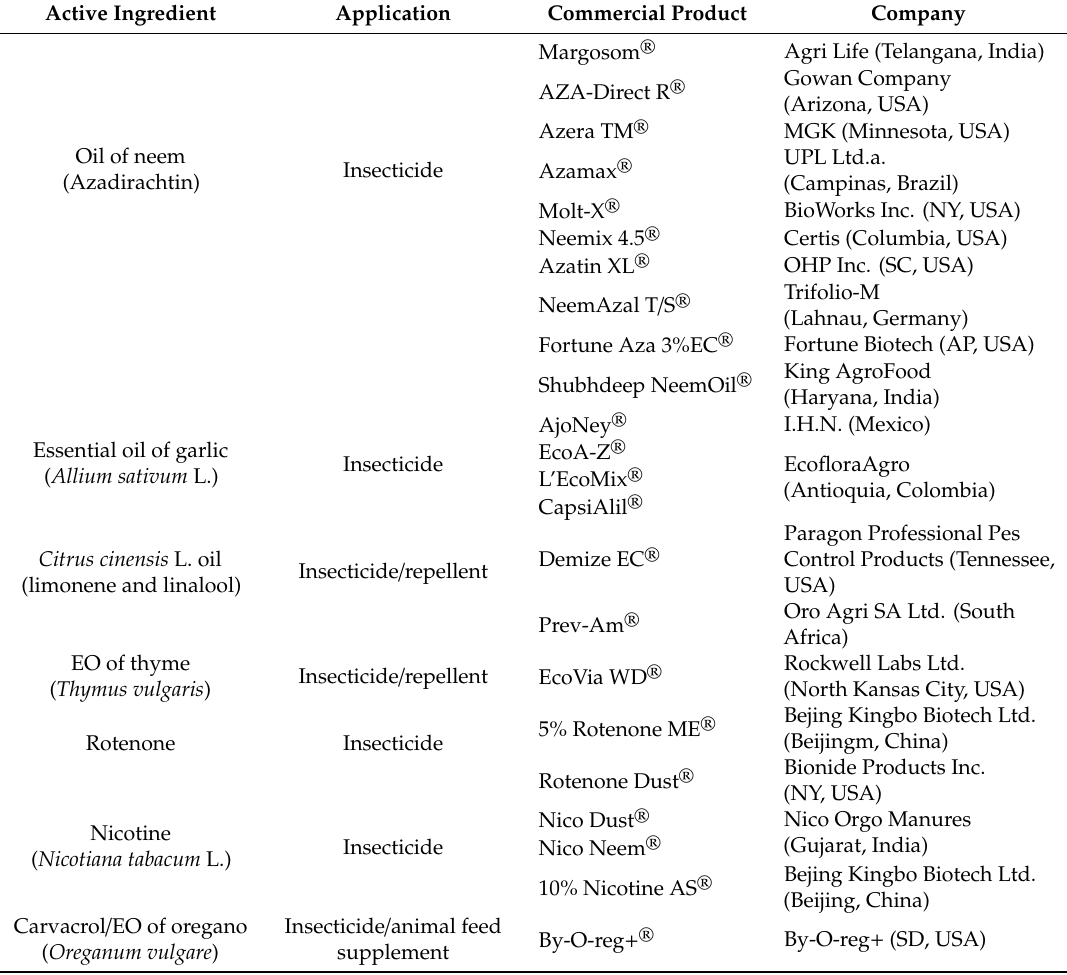
Table 3. Commercially available products based on botanical pesticides